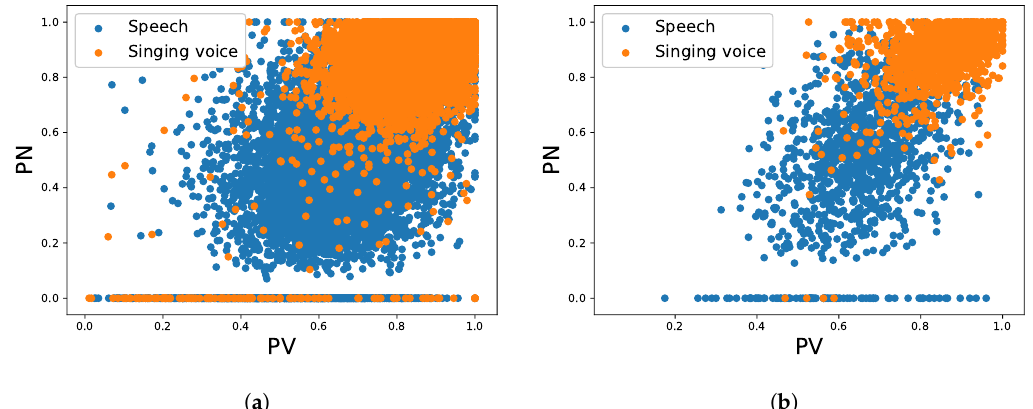
Figure 5. Distribution of PV and PN parameters. ( a ) Bertsolaritza database; ( b ) NUS